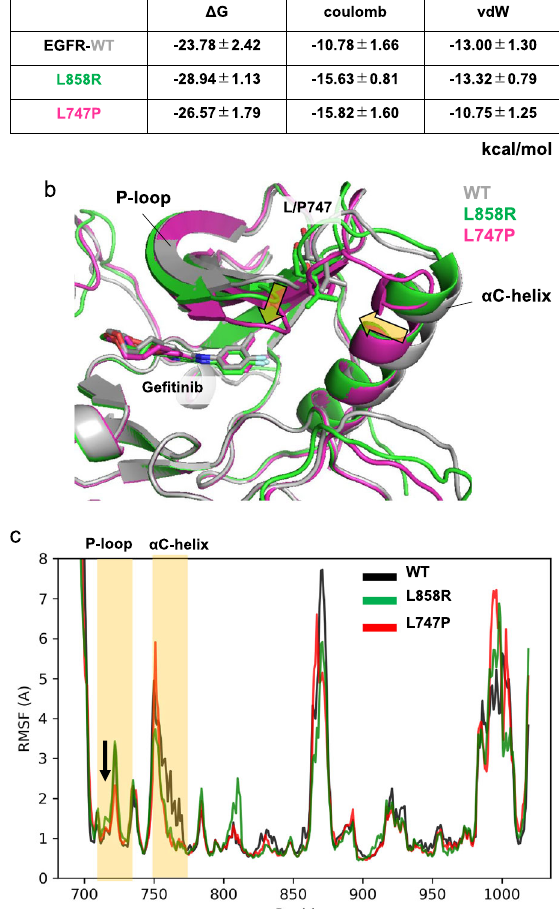
Fig. 3 Computational prediction of the binding af fi nity of ge fi tinib toward EGFR-WT, L858R, and L747P mutants. a Binding free energies ( Δ G) of ge fi tinib toward EGFR-WT, L858R, and L747P mutants. Electrostatic (Coulomb) and van der Waals (vdW) contributions to the Δ G values are also indicated. The binding af fi nity for the L747P mutant is signi fi cantly lower than that for the L858R mutant owing to the loss of vdW interactions. b The mean structures of 1 μ s × 3 MD simulations. The protein backbone is represented by a ribbon diagram, and ge fi tinib and L/P747 are depicted as sticks (C, gray/green/magenta; N, blue; O, red; F, cyan). Orientational changes in the phosphate-binding loop (P-loop) and α C-helix upon the L747P mutation are indicated by yellow arrows. c Root ‐ mean ‐ square fl uctuation (RMSF) of the backbone Ca atoms. RMSF values were calculated using MD trajectories of 1 μ s × 3. P-loop and α C-helix regions are highlighted in yellow. Conforma- tional fl exibility of the P-loop in the L747P mutant is lower than that in WT or the L858R mutant, as indicated by an